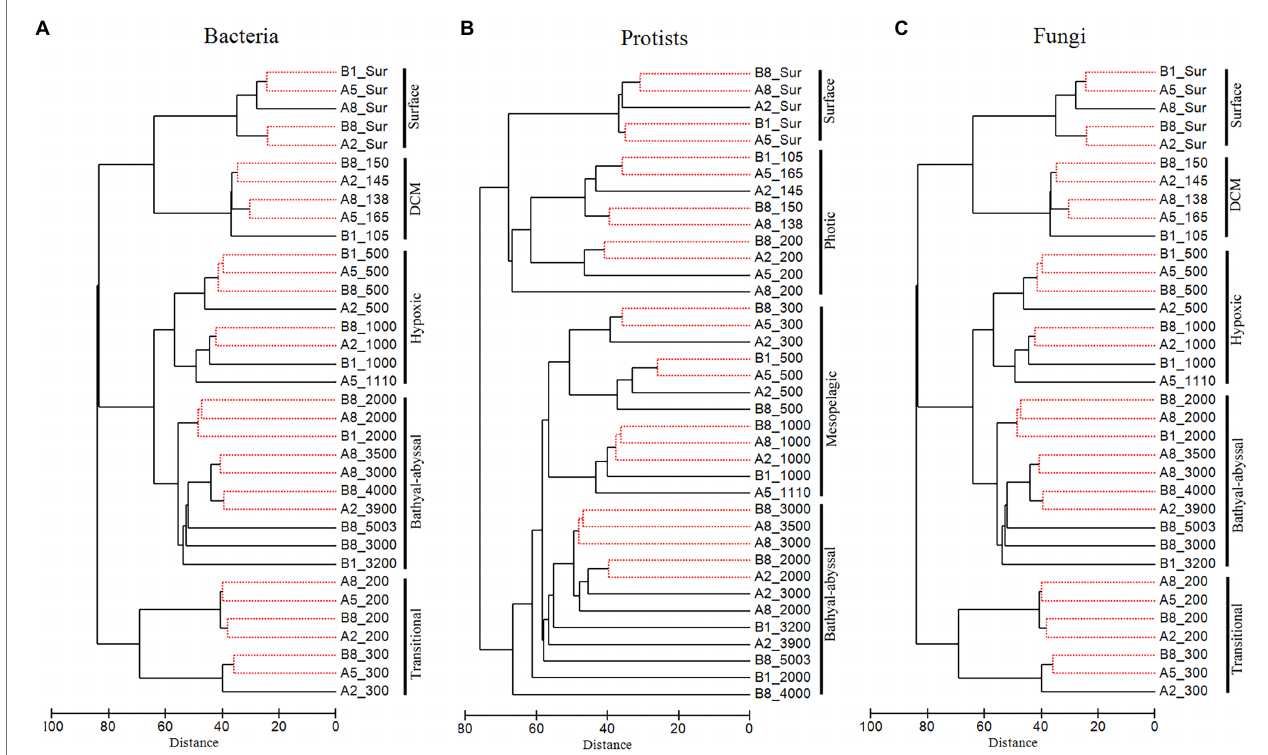
FIGURE 3 | Clustering results for bacteria (A) , protists (B) , and fungi (C) based on the Aitchison distances of samples. No significant differences (SIMPROF, p > 0.05) regarding OTU composition and abundance of sequences were detected among samples connected with a red dashed